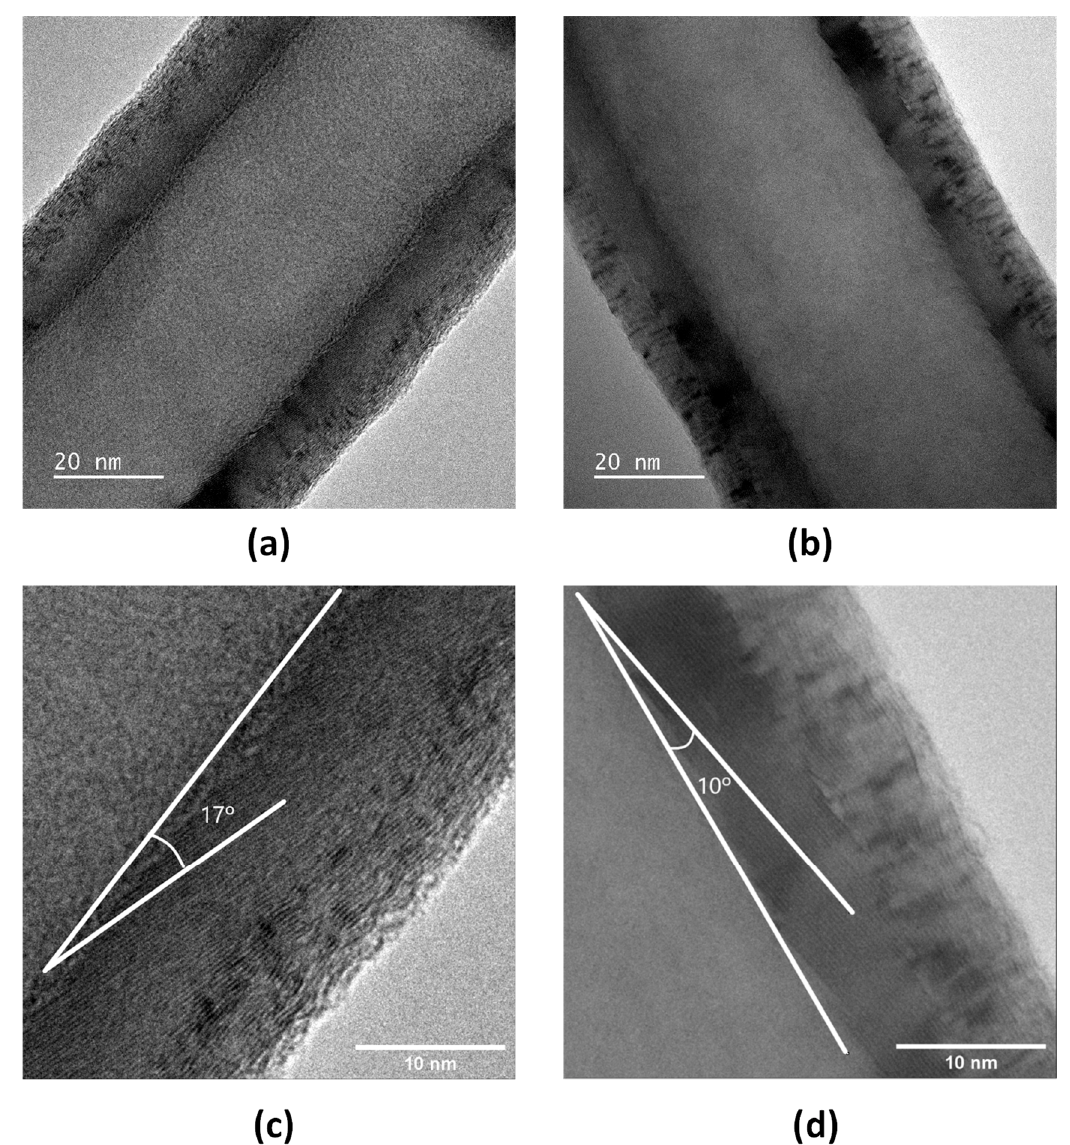
Figure 1. TEM images of Pyrograf ® III carbon nanofibers: ( a ) PR 19 LHT XT and ( b ) PR 24 LHT XT. Detail of inner layers: ( c ) PR 19 LHT XT and ( d ) PR 24 LHT XT. (Figure 1a,c reprinted with permission from Ref. [15]. Figure 1b,d reprinted with permission from Ref. [14]).